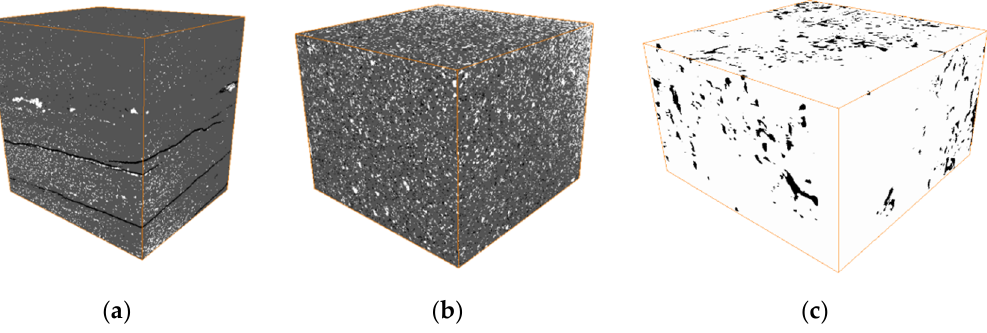
Figure 4. Construction of shale multiscale digital rock: ( a ) microfracture sample; ( b ) micropore subsample; and ( c ) nanopore subsample.